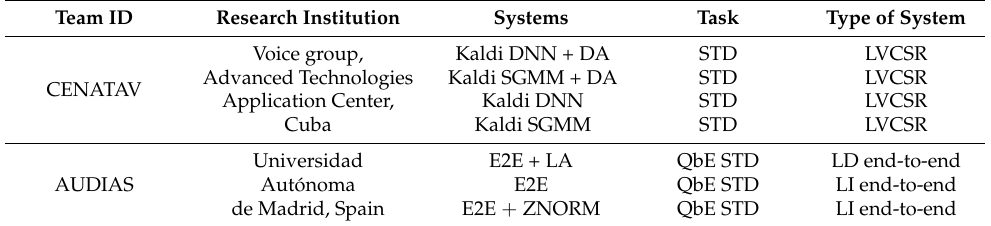
Table 7. Participants in the ALBAYZIN 2020 SoS along with the systems submitted.